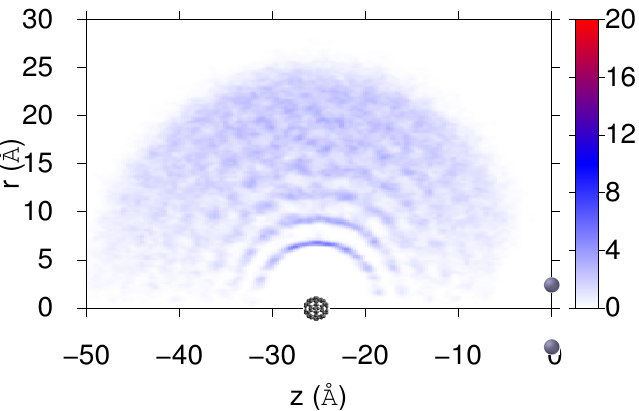
Figure 9. For M = 10 and v 0 = 25.4 m/s, and using cylindric coordinates with z -axis in direction of line joining Cs 2 and C 60 mass centers, final He density distribution ( × 10 − 3 Å − 2 ). Positions of Cs 2 and C 60 impurities are also indicated.